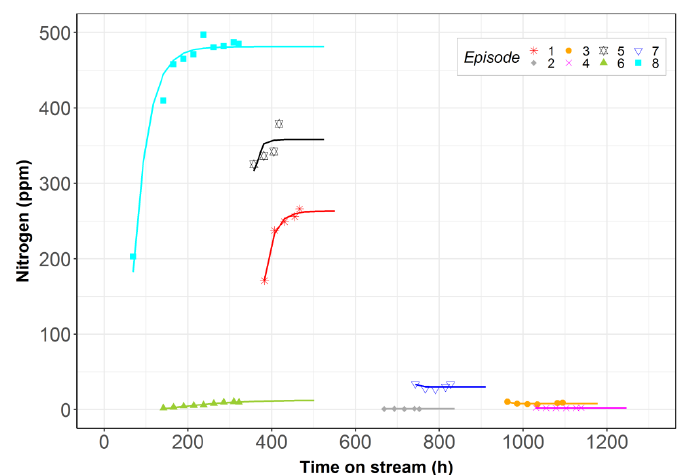
Figure 6. Model calibration using eight episodes selected by the Kennard–Stone algorithm (solid line: simulated by model, points: experimental data). Table 1. Operating conditions of eight selected episodes.